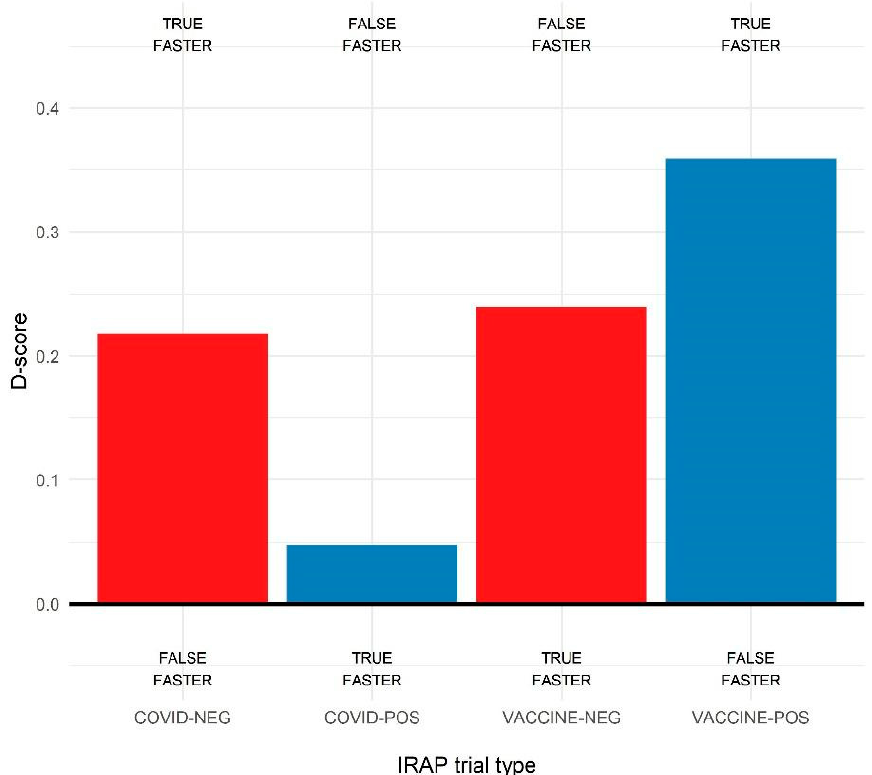
Figure 2. Average D-scores obtained in the four IRAP trial types, with the combination of labels (VACCINE and COVID-19) and targets (POSitive or NEGative). Labels at the top or bottom of the plot indicate the direction of the bias according to the consistent (upper) or inconsistent (lower) rules. As shown, all D-scores were positive, i.e., participants responded faster in the consistent block for all the four trial types.